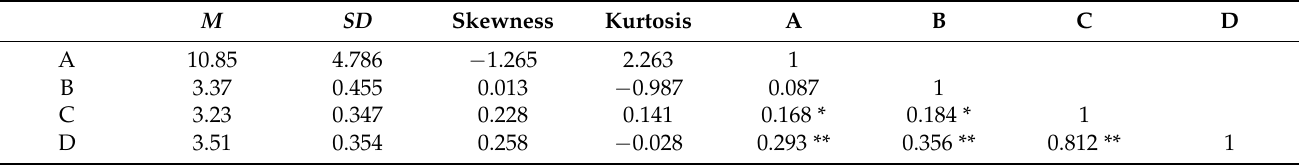
Table 1. Descriptive statistics and Pearson’s correlations of measured